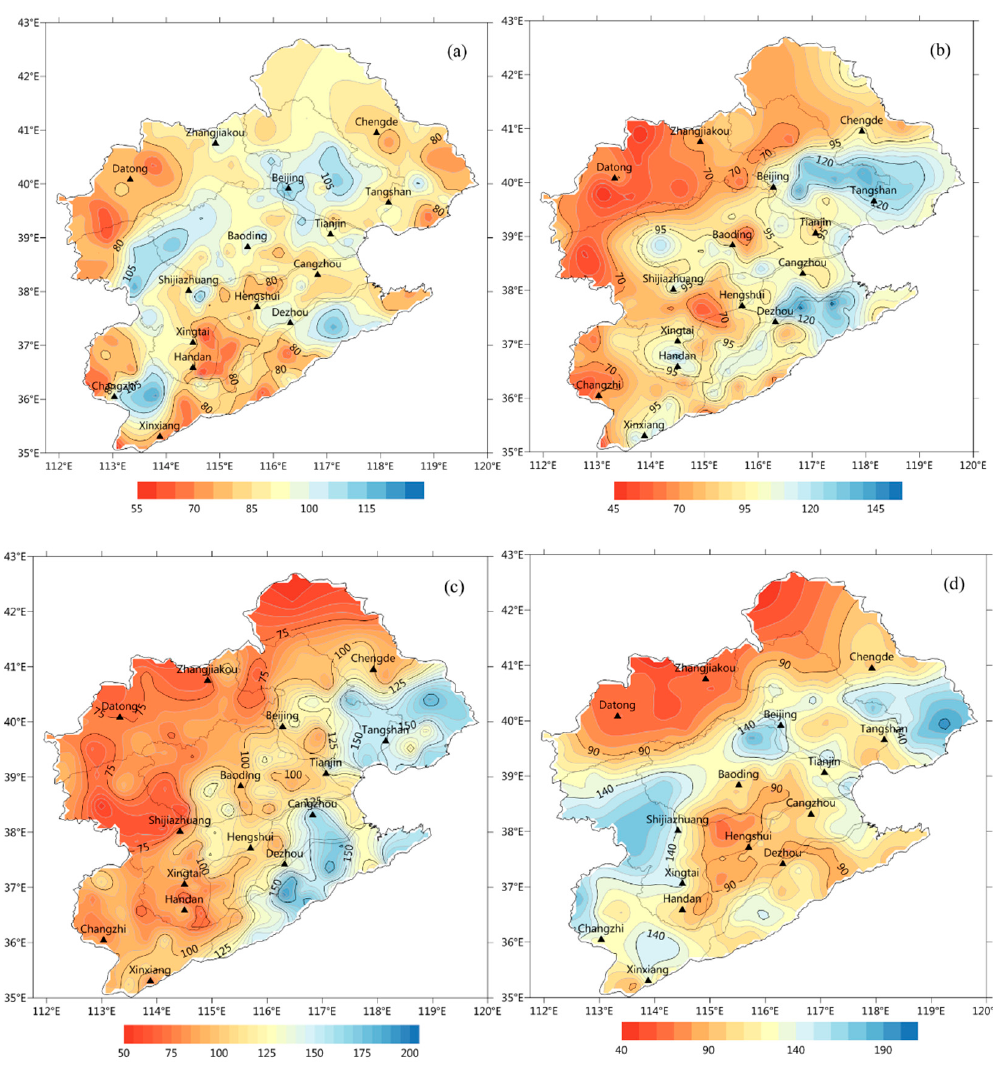
Figure 10. The precipitation amount with different durations in the Haihe River basin, 2007–2017 (unit: mm) (( a ), short-duration (1–3 h) precipitation; ( b ), medium-duration (4–6 h) precipitation; ( c ), long-duration (6–12 h) precipitation; and ( d ), continuous precipitation (over 12 h) precipitation).